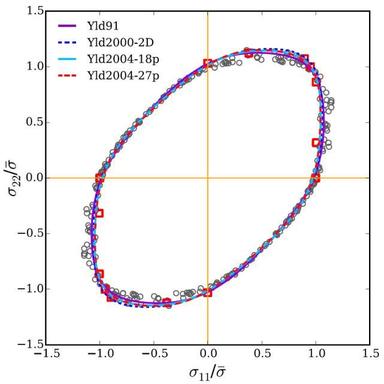
Yield surfaces ( 12 = 0 ) of the cold-rolled AA3104 aluminum alloy predicted by the identified yield functions. ¯ denotes the uniaxial tensile yield stress along the Rolling Direction (RD) obtained from the virtual tests. Open circles denote the yield stress points obtained from the VIRTUAL LABORATORY simulations, open squares denote experimental data from Wu et al.. Yld91, Yld2000-2D (for the plane stress state), and Yld2004-18p are the yield functions proposed by Barlat et al.